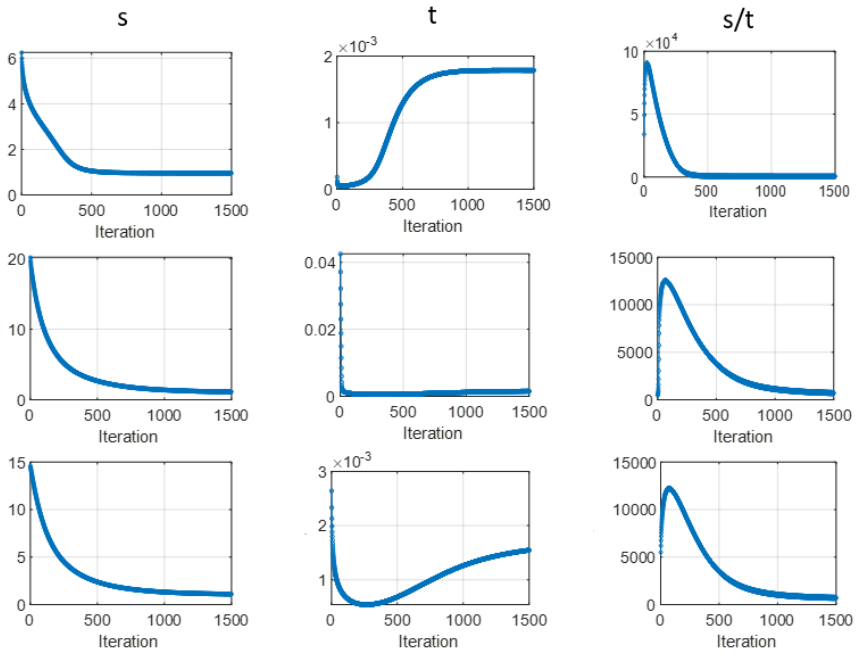
Figure 7. Estimated free parameters by joint-parameter-Bayes along with iterations with three different initials in accordance with Figure 6.